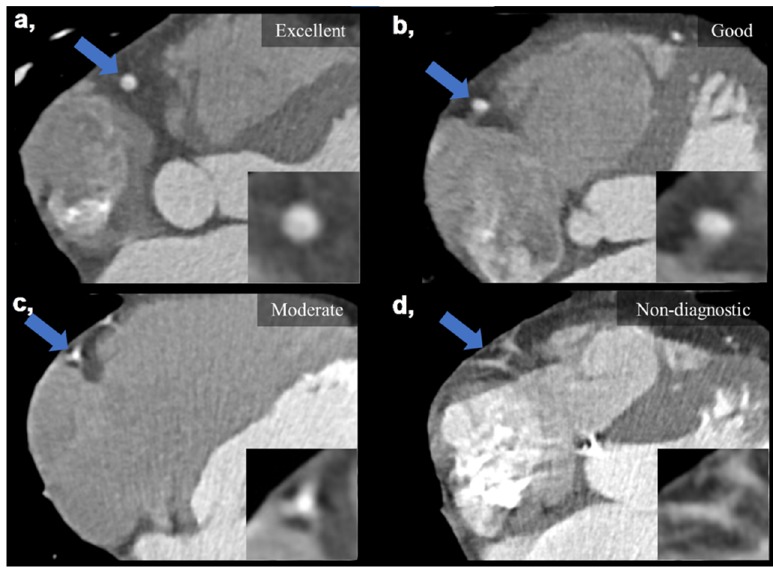
Figure 2. Visual representation of image quality categories on four example images taken on the DCCT. ( a ) Excellent IQ with sharp vessel contours and three grades of motion artifacts degrading the evaluation of the right coronary artery ( b – d ). ( b ) Good IQ—slight motion artifact not affecting luminal assessment. ( c ) Moderate IQ—only the presence of significant stenosis can be ruled out. ( d ) Non-diagnostic IQ—no luminal assessment is possible. Blue arrows mark the middle segment of the right coronary artery, which is also enlarged in the right lower corners of the images. DCCT: dedicated cardiac CT, IQ: image quality.